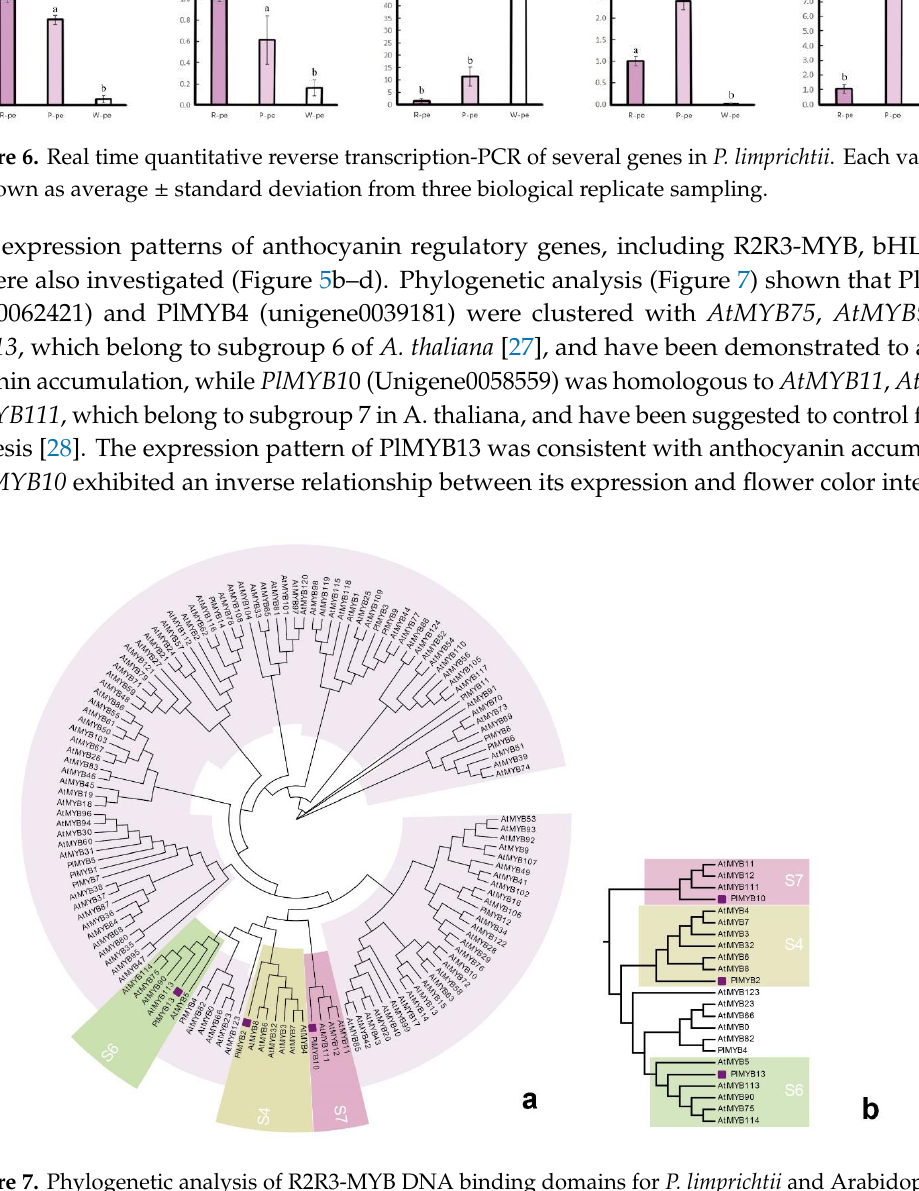
Figure 7. Phylogenetic analysis of R2R3-MYB DNA binding domains for P. limprichtii and Arabidopsis thaliana. ( a ) Circular phylogenetic tree; ( b ) amplification of S4, S6, and S7 branches. The R2R3 domains of the 14 MYBs identified in P. limprichtii petal transcriptome were aligned and analyzed using neighbor-joining phylogenetic methods.